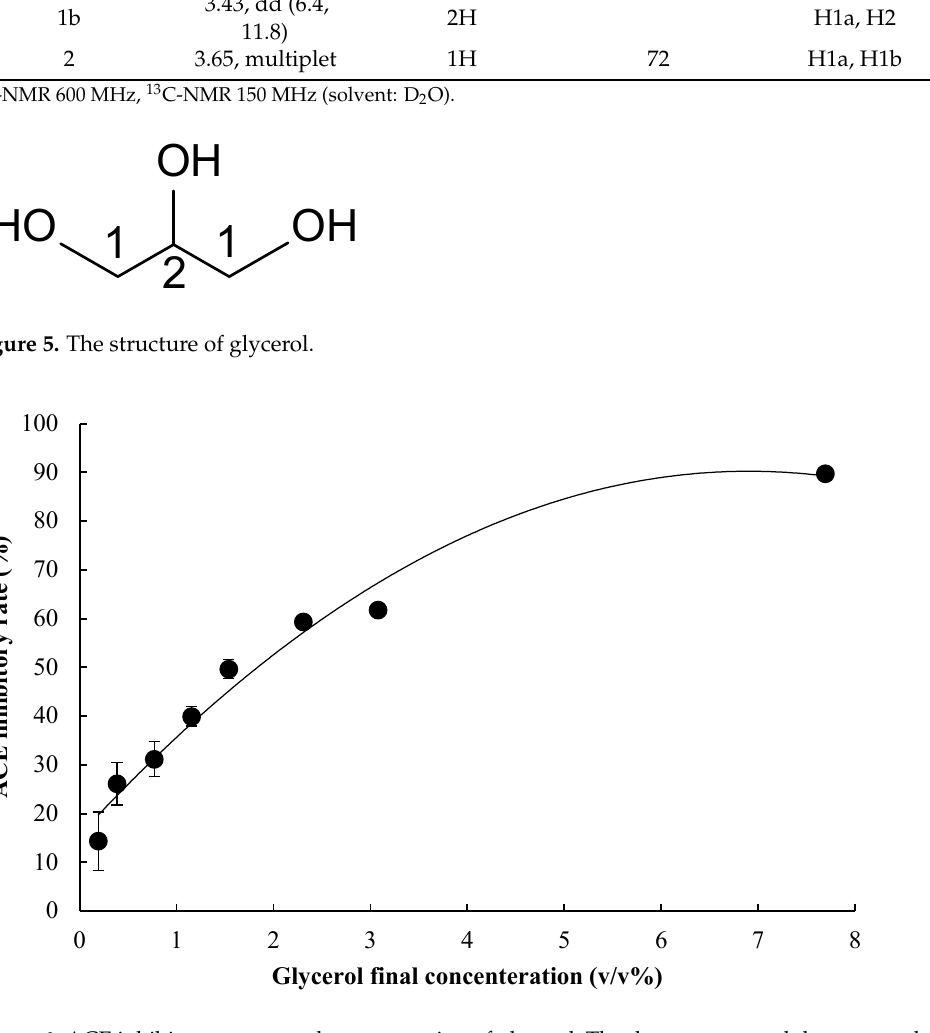
Figure 6. ACE inhibitory rate at each concentration of glycerol; The data represented the mean values ± standard error ( n =